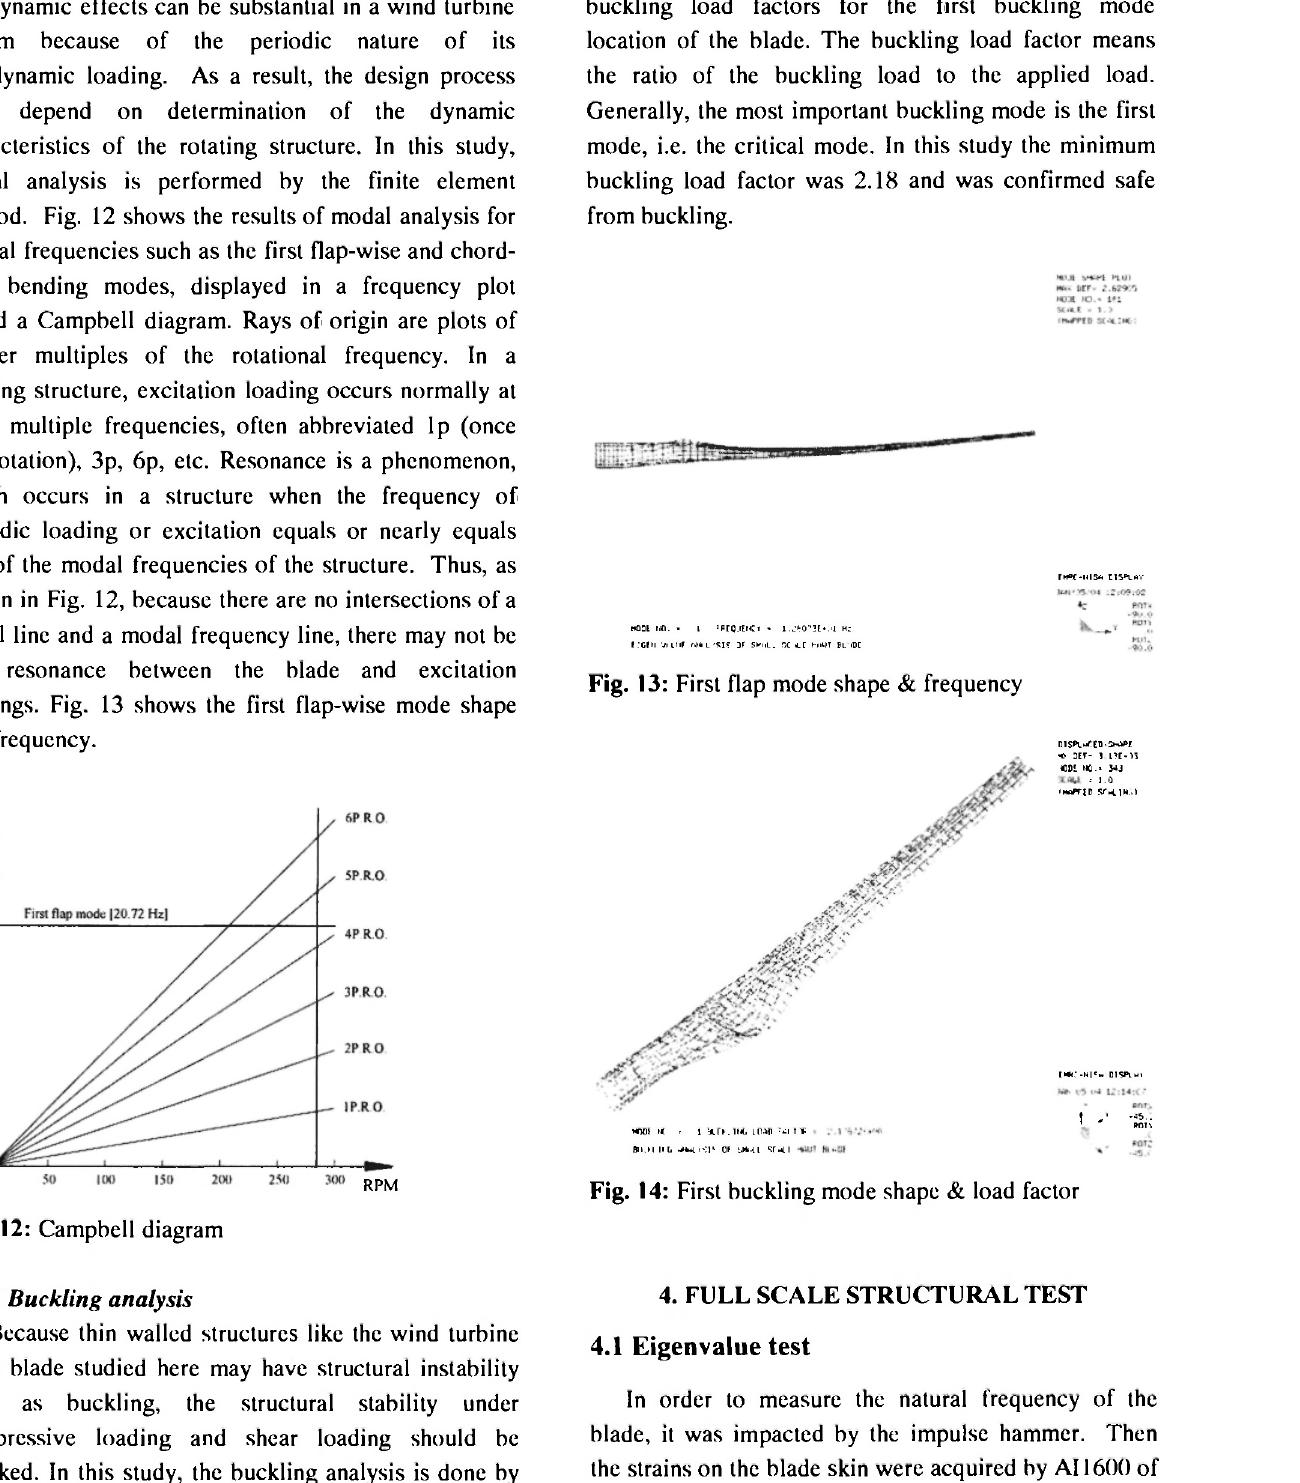
Fig. 14: First buckling mode shape & load factor